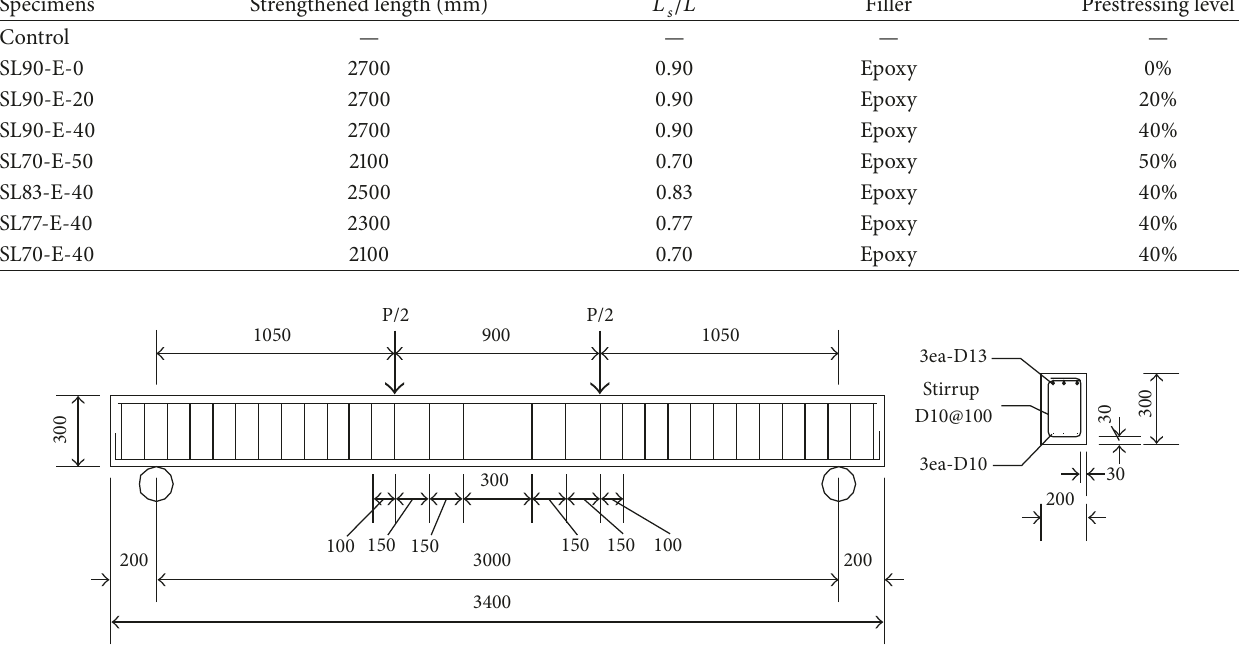
Figure 2: Details and cross-section of specimens (mm).